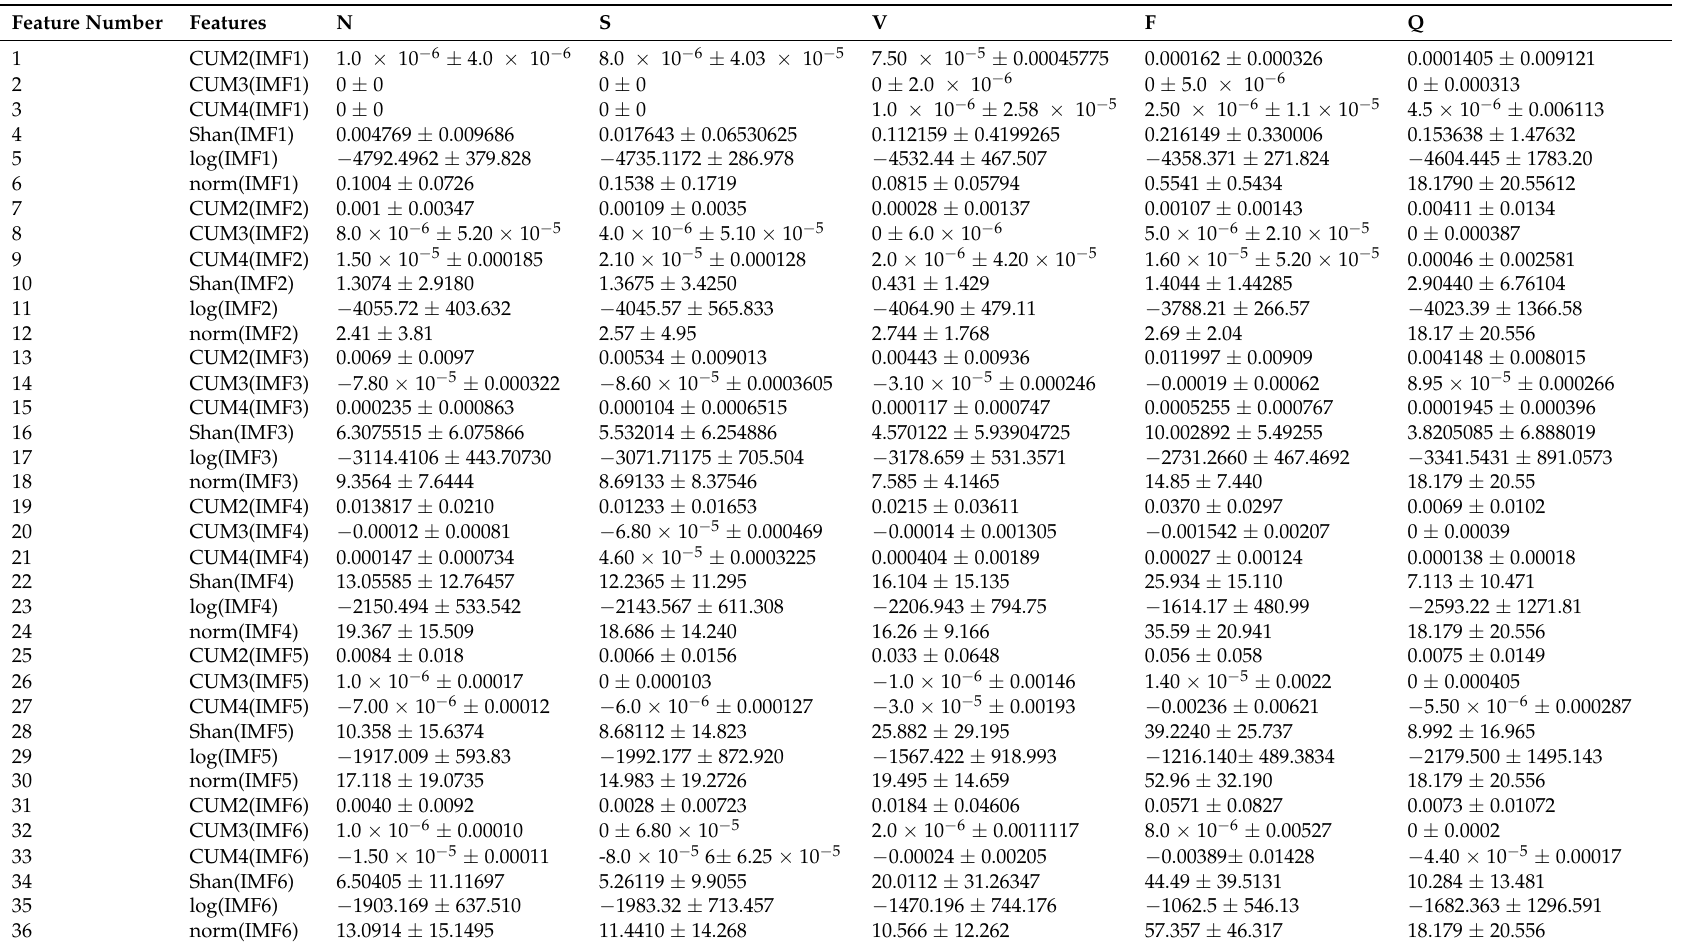
Table 26. Median ± interquartile range of features extracted on